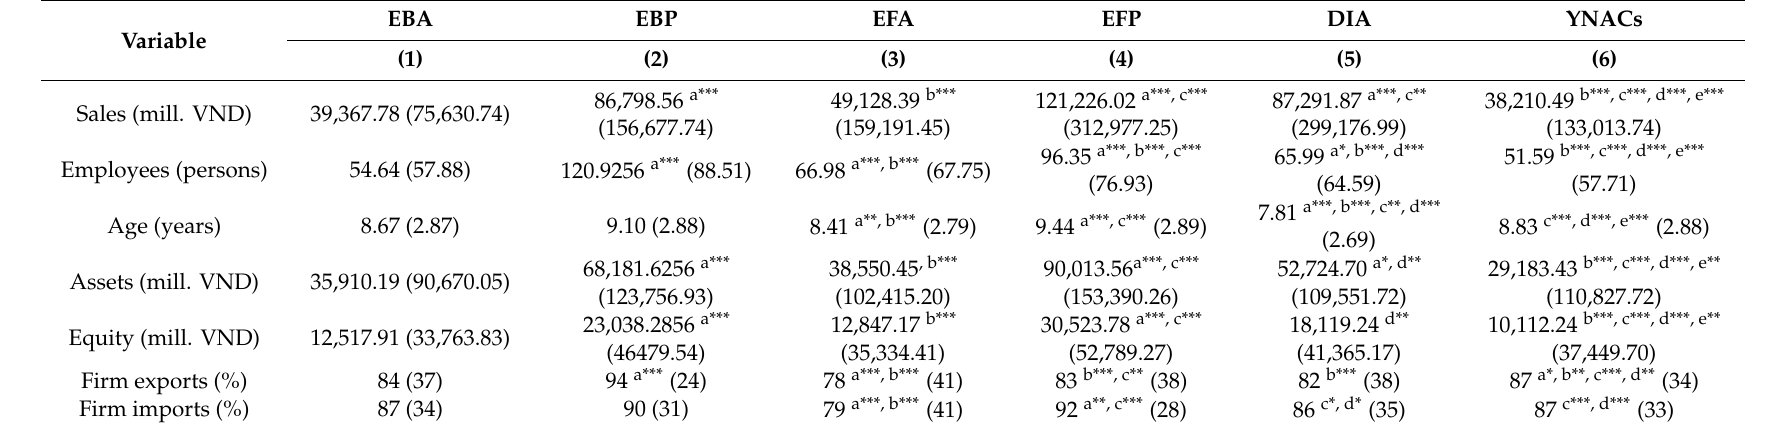
Table 4. Descriptive summary, young SMEs (average